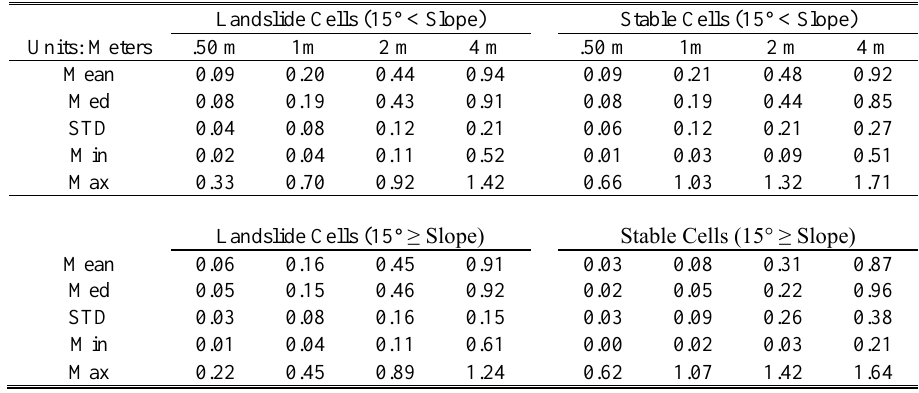
Table 2. Statistics of roughness surface feature.